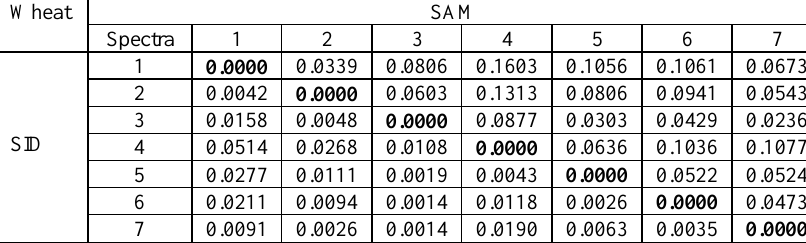
Table 2: SAM and SID among Wheat field spectra